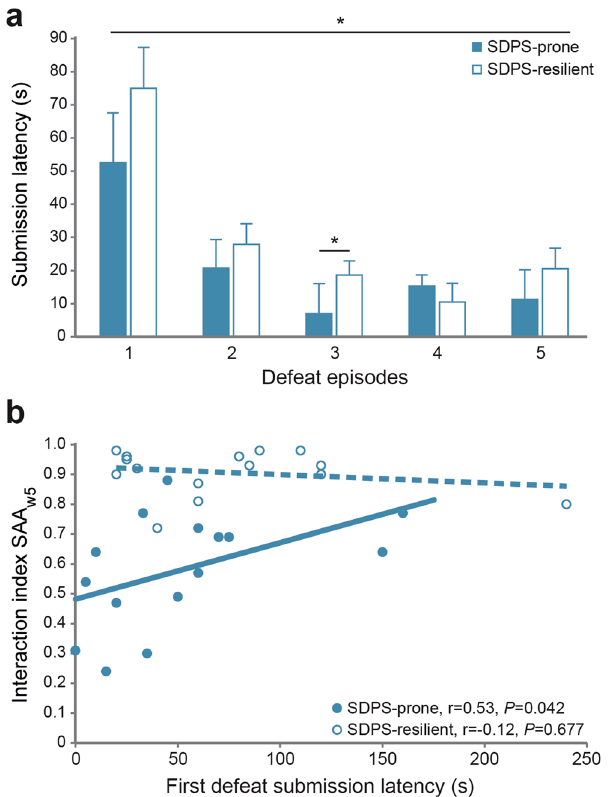
Figure 4. Submission latency during social defeat. Latency to assume the first submissive posture during the five defeat sessions was documented for each SDPS animal. ( a ) Following the two-steps cluster analysis, average latency to first submission was calculated for each of the emerging SDPS-prone and SDPS-resilient subgroups. SDPS-prone animals displayed shorter submission latency over the five defeat sessions and this effect was most pronounced in day 3 of the social defeat period. ( b ) In the SDPS-prone group, submission latency during the first defeat episode was positively correlated with social avoidance as assessed at the SAA w5 test, which was the most prominent predictor of SDPS-proneness in the affective domain. No such correlation was observed for the SDPS-resilient rats. Spearman’s rank correlation coefficient (r) and the correspondent P -value is indicated for each group. * P <